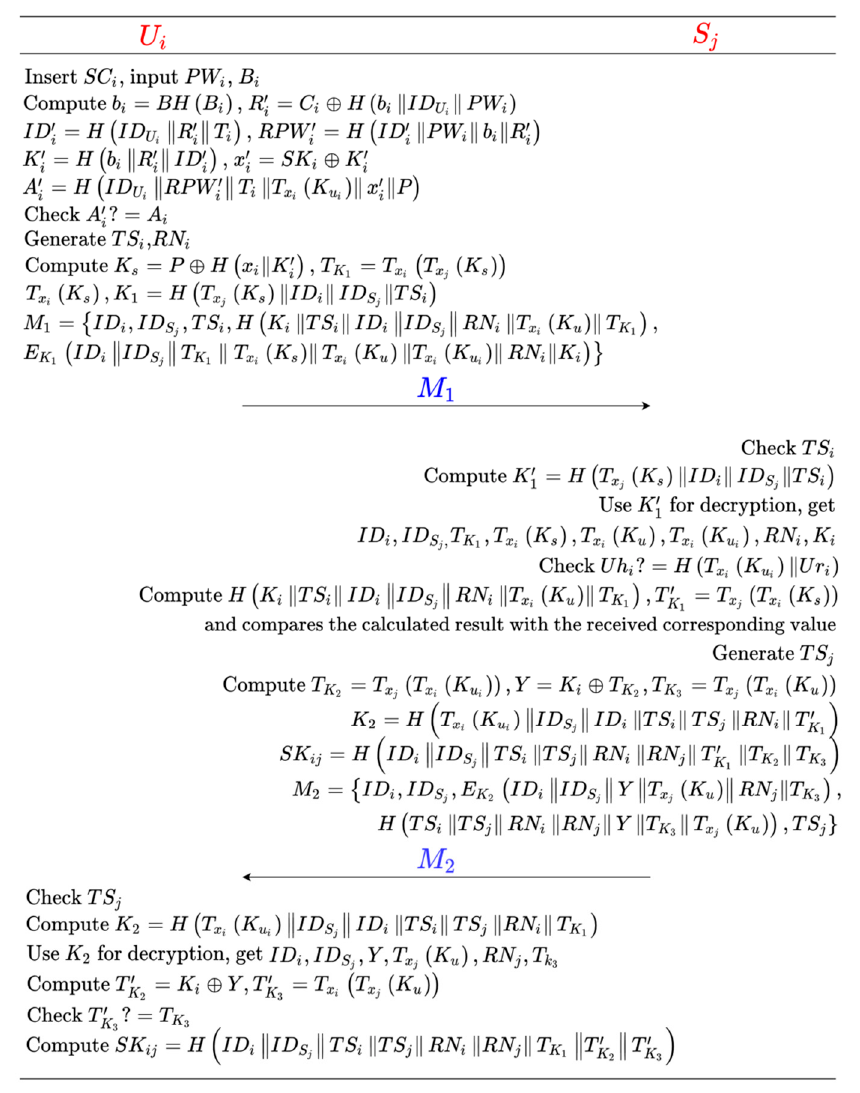
Figure 3. L ogin and authentication phase of Chatterjee et al.’s scheme. Figure 3. Login and authentication phase of Chatterjee et al.’s